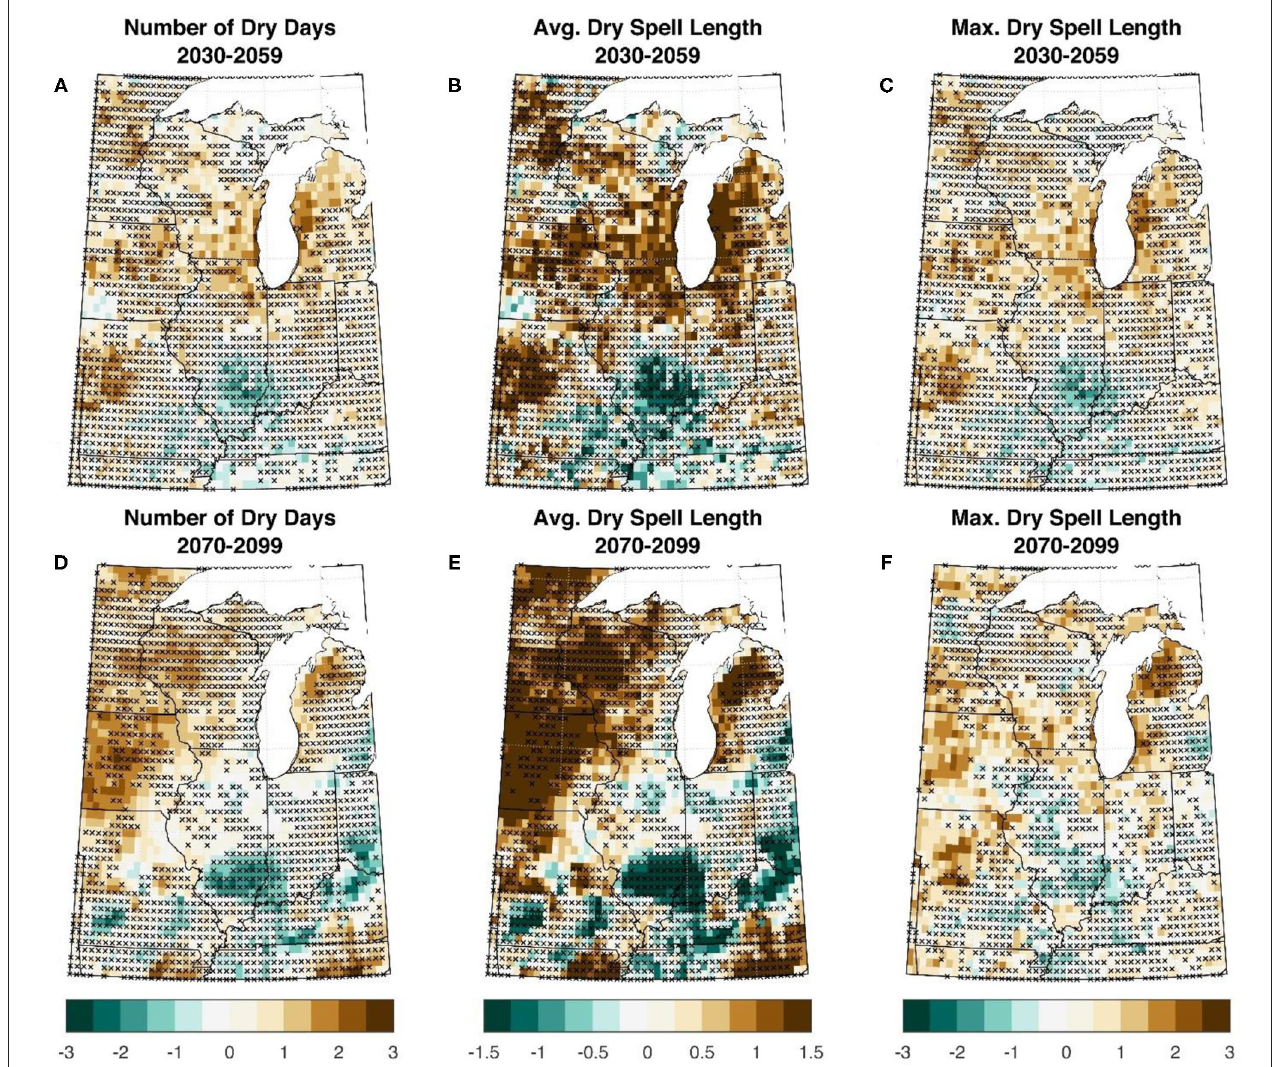
FIGURE 6 | The projected change in the 30-year summer climatology of the NA-CORDEX multi-model ensemble median in mid- (2030–2059) and late-century (2070–2099), relative to the model historical period (1976–2005). Shown are the number of dry days (A,D) , the average dry spell length (B,E) , and the maximum dry spell length (C,F) . Stippling represents areas where fewer than 9 of the 12 simulations agreed on the sign of the projected